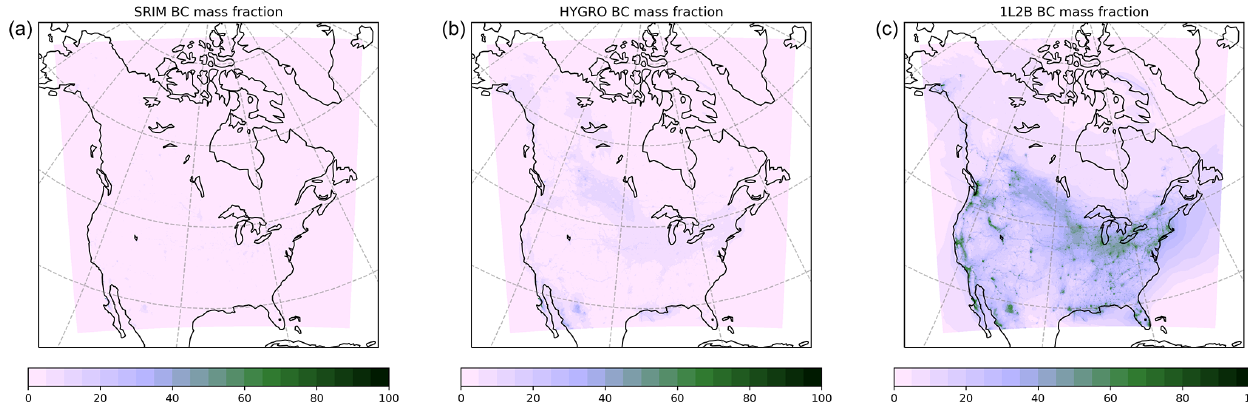
Figure 5. Black carbon mass fractions in BC-containing particles. Values are given at the surface and weighted by the BC mass in each size bin and mixing-state category. Values are shown for the following simulations: (a) SRIM, (b) HYGRO, and (c) 1L2B.